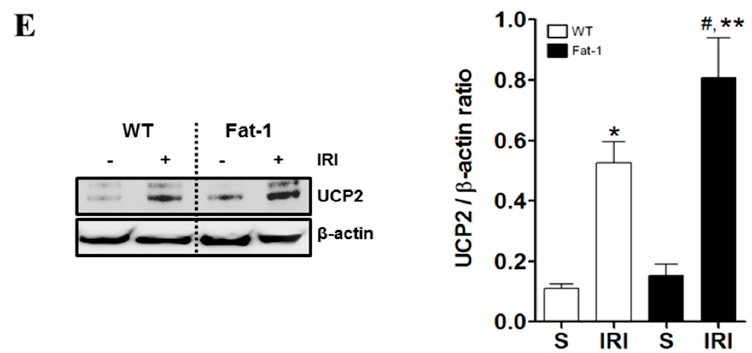
Figure 3. Oxidative stress in ischemia-reperfusion (IR) kidney showing the representative kidney section of reactive oxygen species (ROS) generation in mouse (WT-S, wild type sham; WT-IRI, IR renal injury in wild-type mice; fat-1, fat-1 induction sham; and, fat-1 ischemia-reperfusion injury (IRI), IR renal injury in fat-1 induction mice). ( A ) DCFH-DA staining, detection of H 2 O 2 . Scale bar = 50 μ m; ( B ) Docosahexaenoic acid (DHA) staining, detection of O 2 production. Fat-1 IR mice kidney showed decreased fluorescence intensity of DCFH-DA and DHA compared to wild type IR mice kidney. Scale bar = 50 μ m; ( C , D ) Real-time polymerase chain reaction (PCR) detection of p22phox and UCP2 mRNA expression in mouse tissues. Data were normalized using β -actin mRNA. Each bar graph, quantification; and ( E ) Evaluation of anti-UCP2 antibody by immunoblot analysis. Left panel: whole tissue lysates from wild and transgenic fat-1 mice were electrophoresed and immunoblotted with anti-UCP2 antibody. Right panel: quantification of densitometry. Data were normalized using β -actin. * p < 0.05 vs. WT-sham kidney, # p < 0.05 vs. fat-1-sham kidney, ** p < 0.05 vs. WT-IR kidney. Bar represents mean ± S.D.